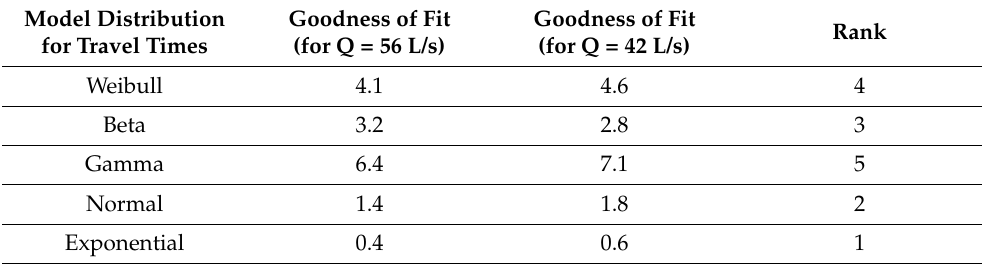
Table 2. Goodness of fit results and corresponding ranking for a range of distributions modelling hop travel times for the minimum and maximum flow rates used in the experiment. Model